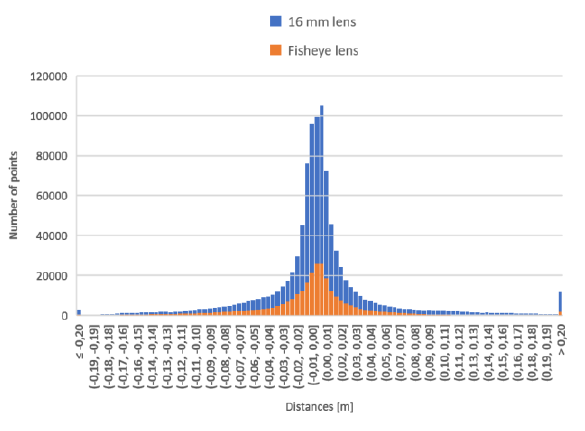
Figure 5. Histogram of set of distances for walls